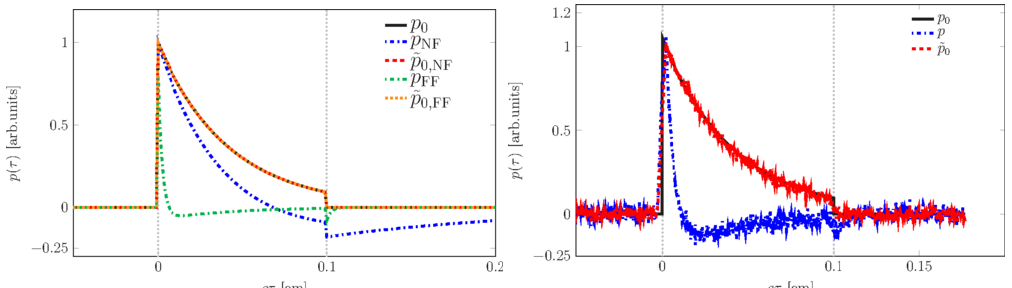
Figure 19. Inverse reconstruction of the initial stress profile ( ˜ p 0, NF , ˜ p 0. FF ) from calculated optoacoustic signals ( p NF , p FF ) in the near and far field, respectively, matching perfectly the true initial stress profile p 0 ( left ). The right panel shows that the reconstruction also works convincingly with signals including a realistic noise component (Gaussian white noise, S/N:5) (reproduced with permission from [107]).